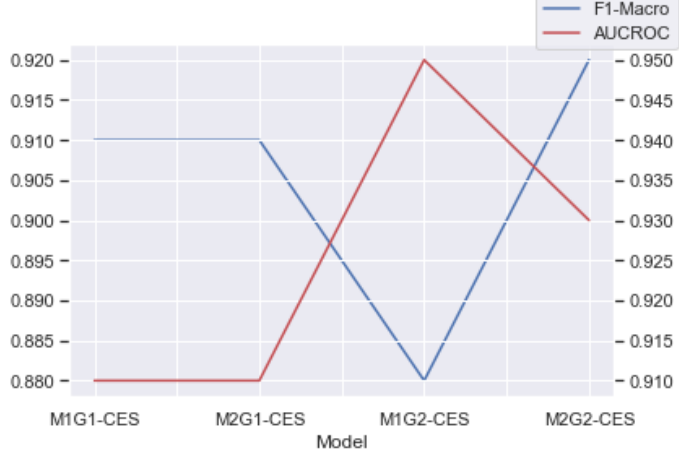
Figure 5. Performance of the models along the grades for the CES